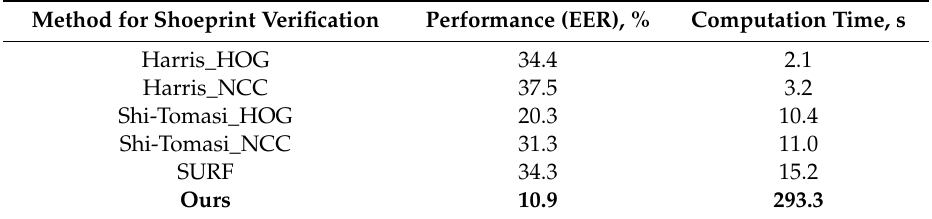
Table 3. Summary of the experiments in terms of shoeprint verification performance on the MUES-SV2HS2S dataset measured by the